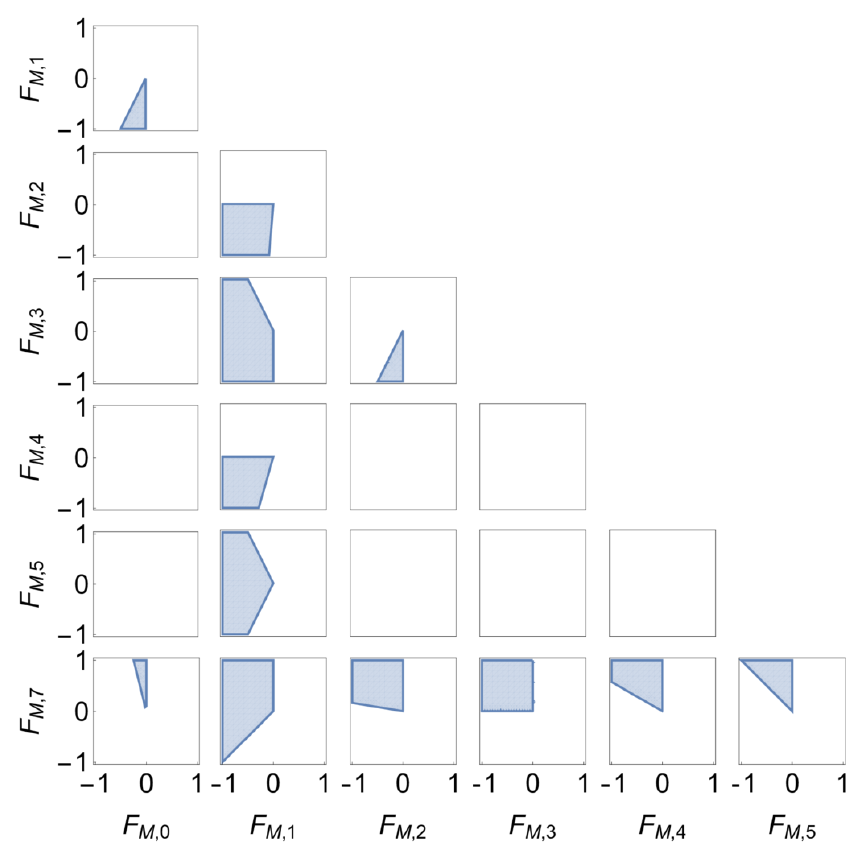
Figure 21 . Positivity constraints on all F M;i pairs.